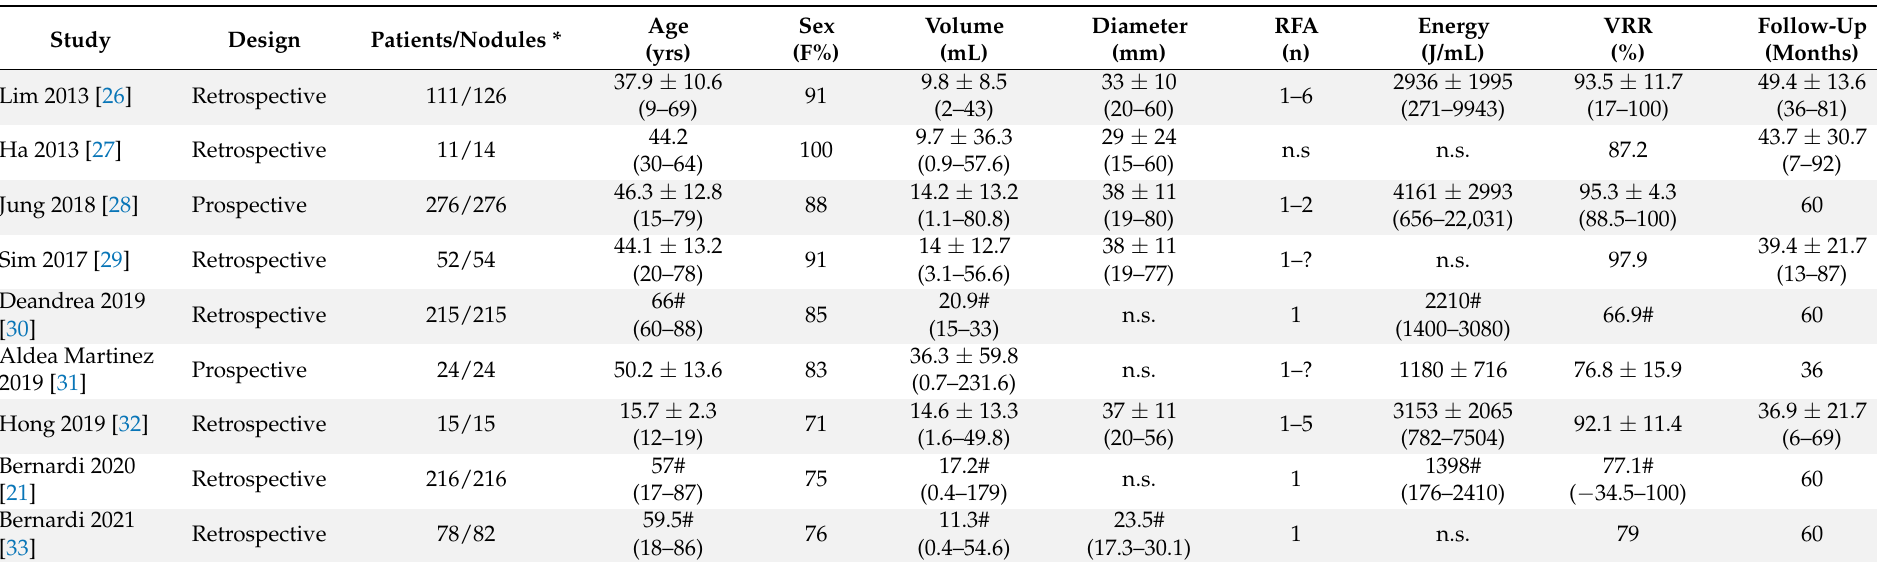
Table 2. Main characteristics of studies on RFA long-term outcomes in patients with benign thyroid